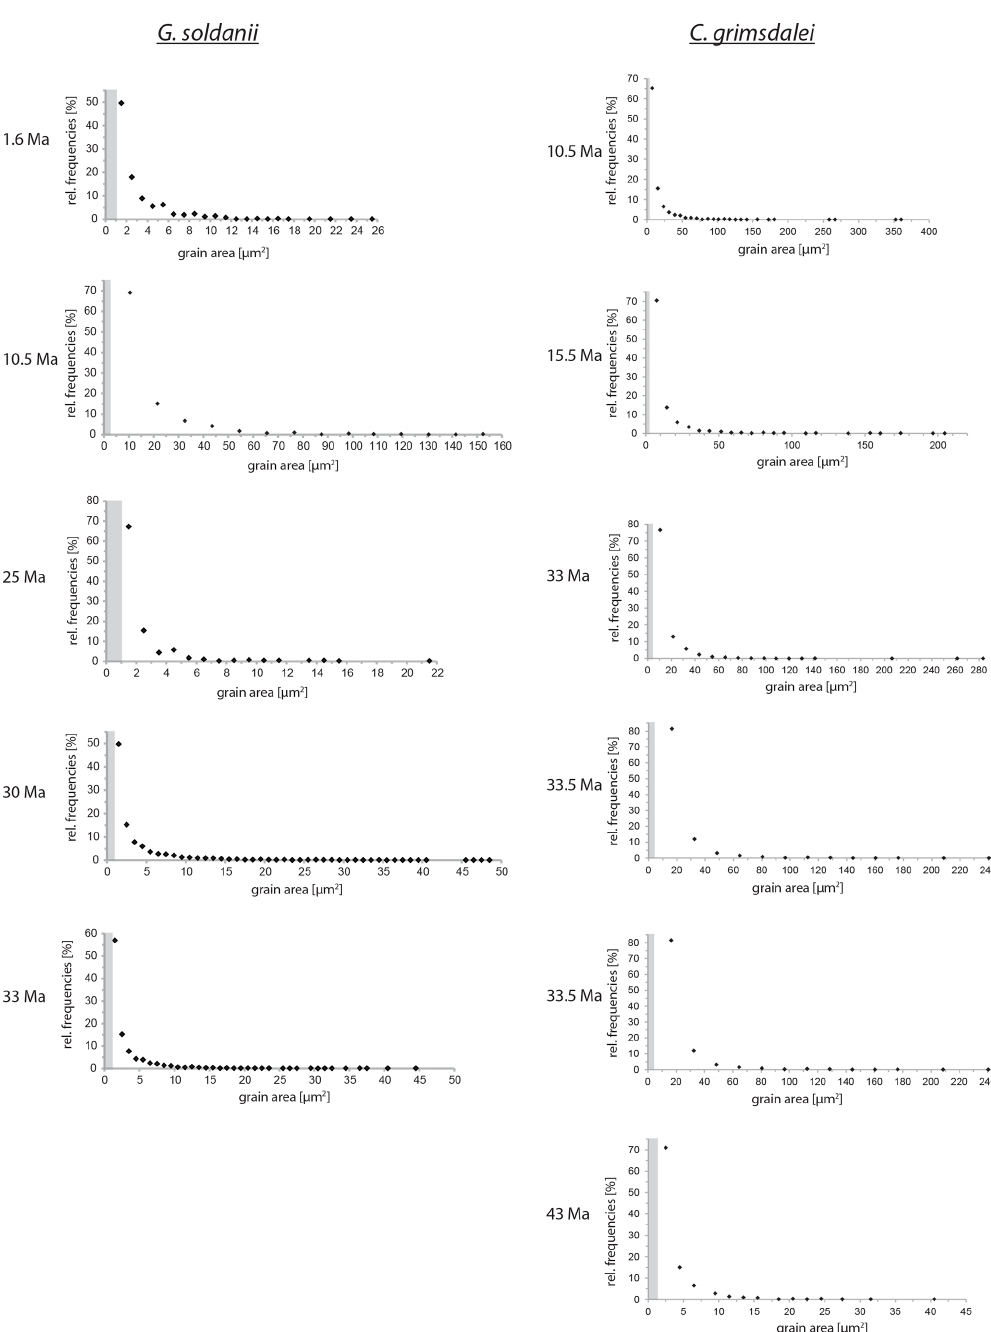
Figure 5. Grain size distribution of Cibicidoides grimsdalei and Gyroidinoides soldanii . The maximum is at the lowest value for each specimen. Crystallite sizes are at 1µm scale. The step sizes are marked as grey dashed